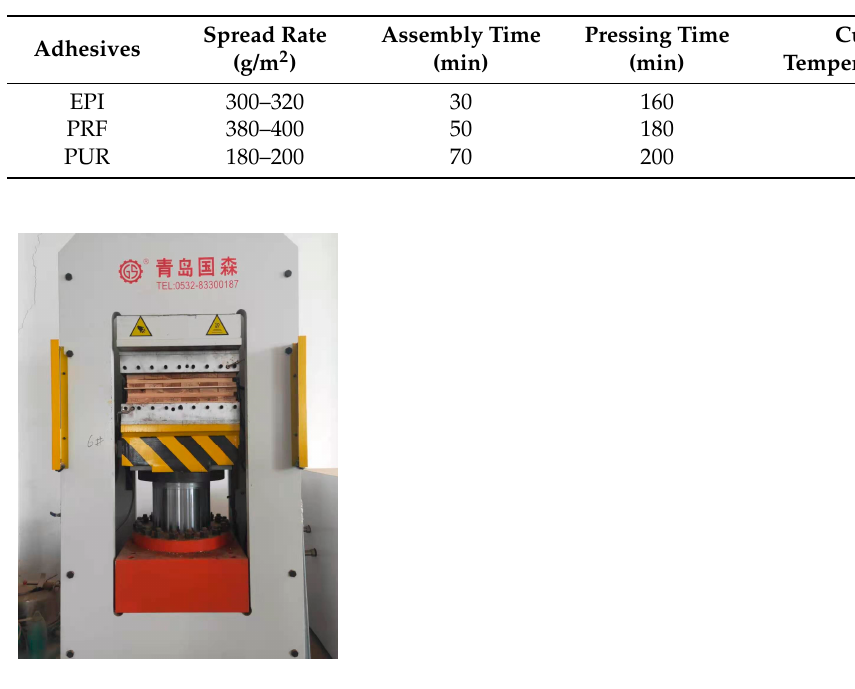
Table 1. Gluing process parameters.